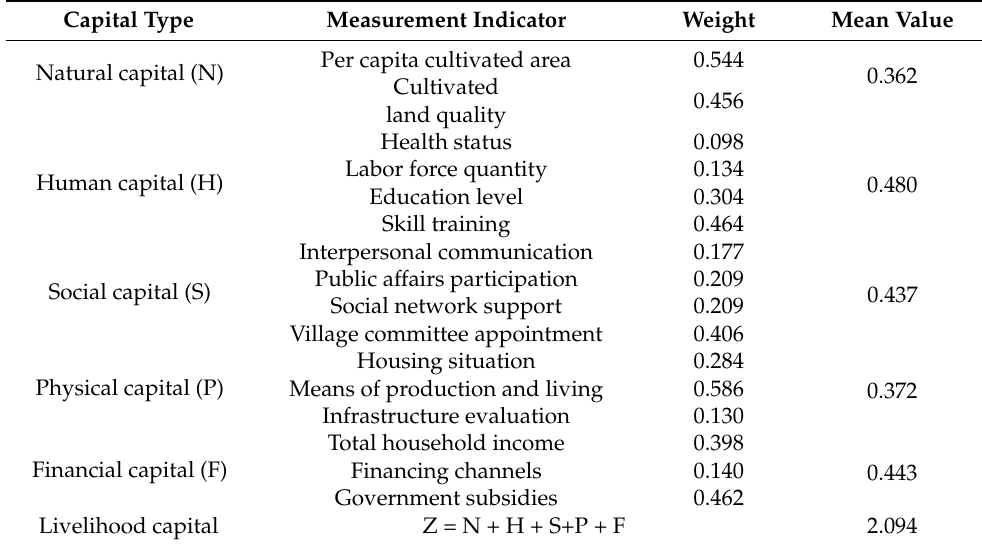
Table 4. Evaluation results of the livelihood capital.